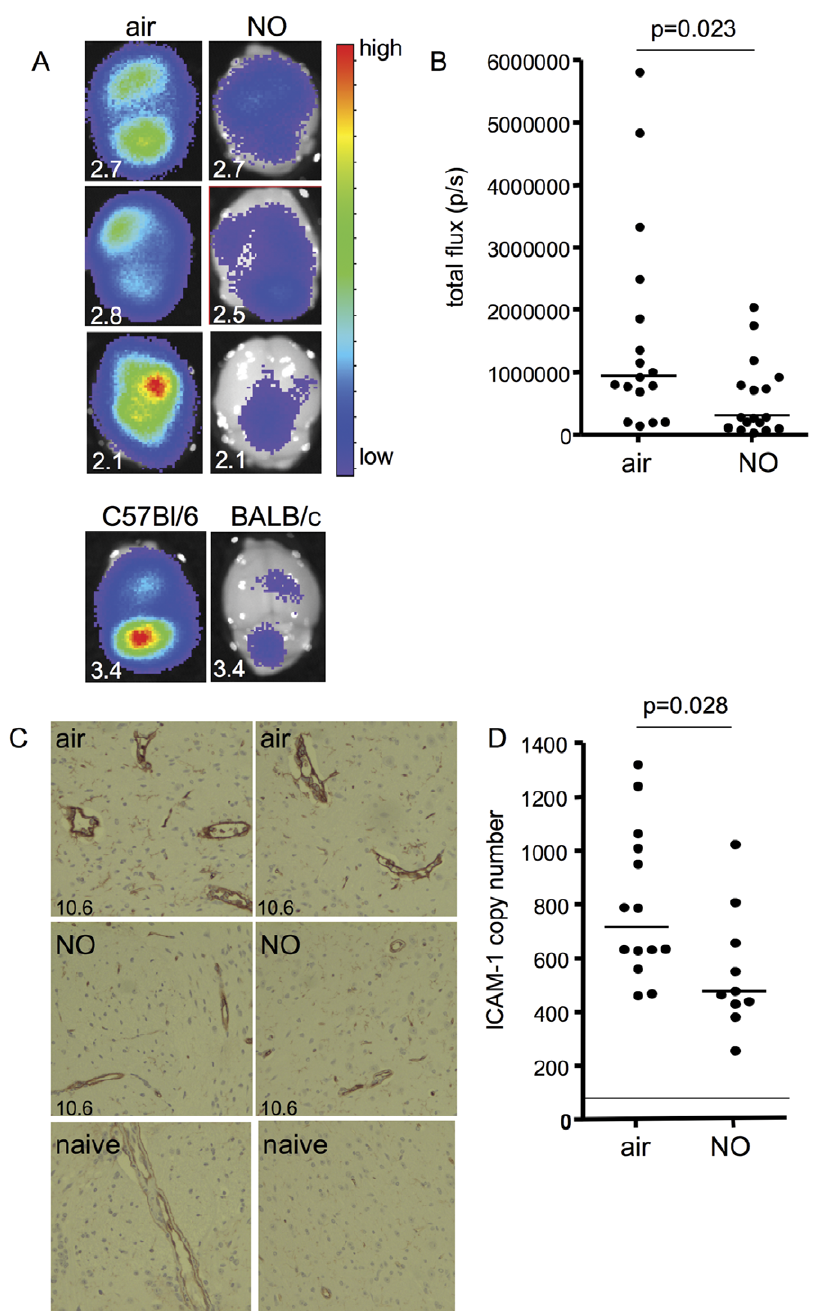
Figure 4. Inhaled NO reduces PE accumulation and ICAM-1 expression in the brains of P. berghei ANKA infected mice. (A) Luminometer imaging of brains collected on day 4 post-infection from mice infected with P. berghei ANKA–GFP–luciferase PEs and prophylactically treated with either air (left panels) or 80 ppm NO (right panels). The rainbow scale represents the relative level of luciferase activity (correlates with parasite load). The numbers on the lower left corner are the peripheral parasitemia levels for each mouse. The bottom panels are brains from a C57BL/6 mouse on the left and a BALB/c mouse on the right. (B) To quantify the brain bioluminescence, total flux (photons per second) was calculated for each brain. p=0.023 by Mann-Whitney test, n=17 per group. (C) Immunohistochemistry analysis of ICAM-1 on formalin fixed brain sections from parasitemia matched mice infected with P. berghei ANKA and prophylactically treated with either air (top panels) or 80 ppm NO (middle panels), or uninfected mice (bottom panels). (D) ICAM-1 mRNA expression displayed as copy number was quantified by quantitative real time PCR in the brains of parasitemia matched infected mice prophylactically treated with air or 80 ppm NO. The line represents the median copy number for uninfected mice. p= 0.028, by Mann-Whitney, n=14 for air, n=10 for NO.